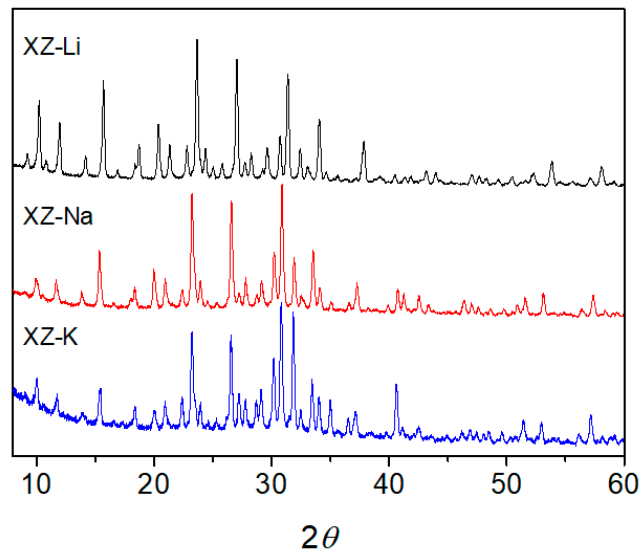
Figure 2. XRD patterns of XZ-M (M = Li, Na and K).